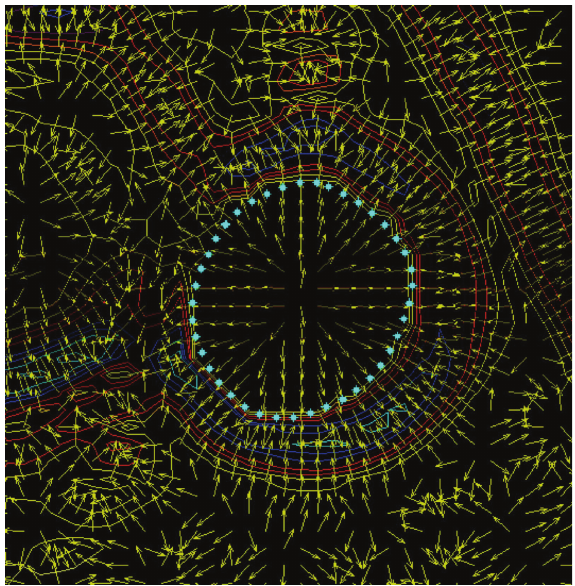
Figure 2: Gradient forces in a PDW image a ff ecting the GVF snake. Curves of di ff erent colour indicate di ff erent gray-levels in the image, yellow arrows represent the external forces acting on the snake during its motion, and cyan star signs mark the final equilibrium position of the